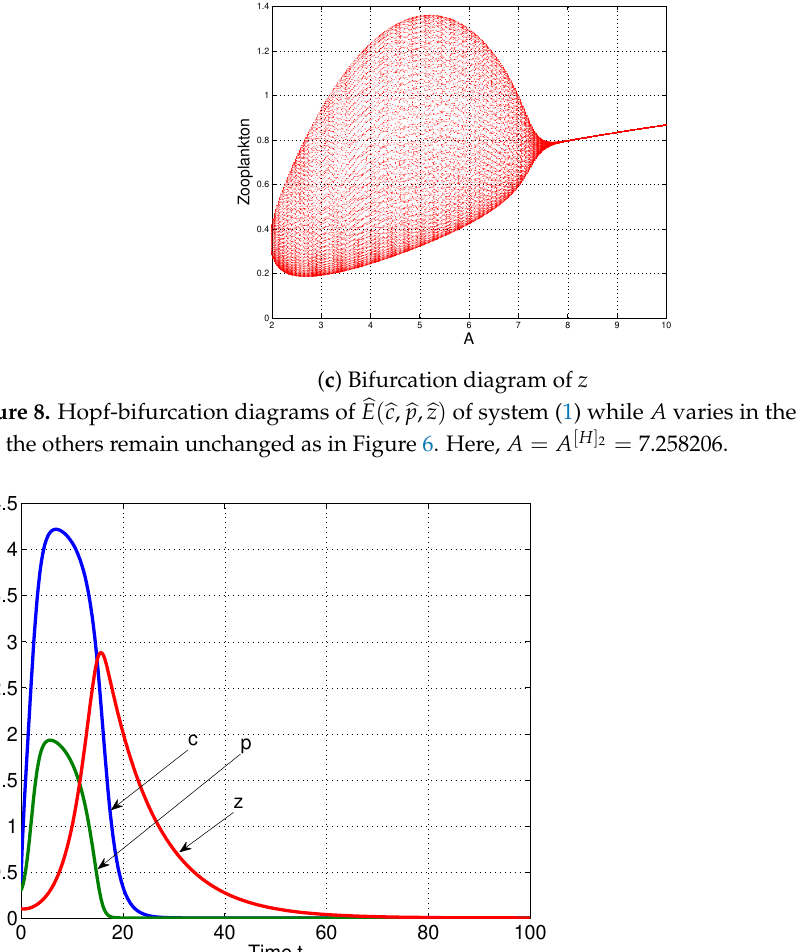
( 2 ) ( 2.04036,1.58281,0 ) and ( b ) E ( 2 ) 1